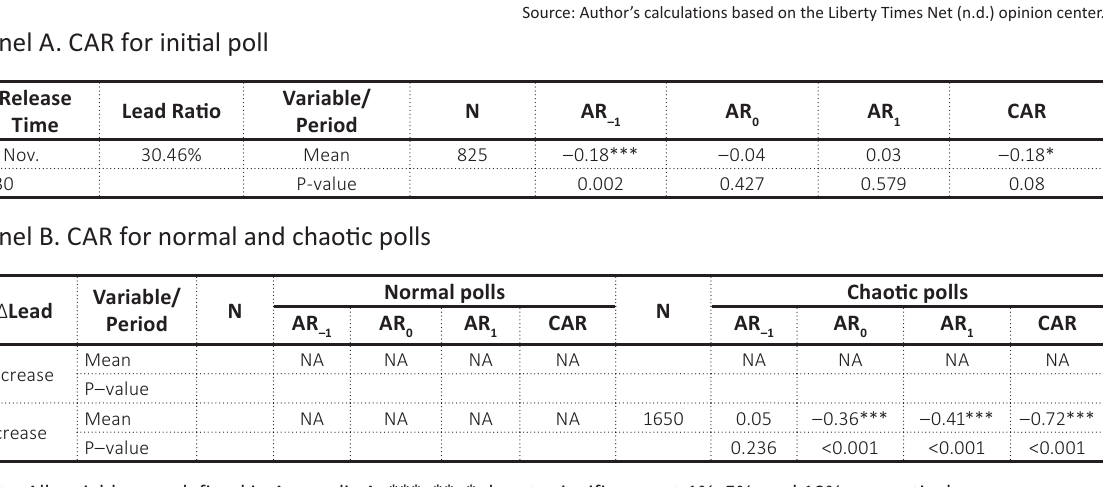
Source: Author’s calculations based on the Liberty Times Net (n.d.) opinion center.